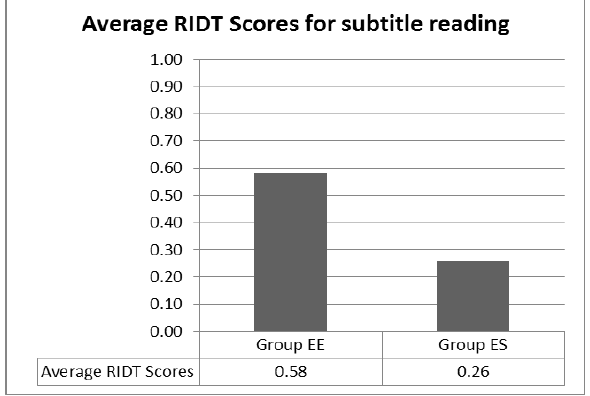
Figure 3. RIDT scores for subtitle reading In spite of the attention allocated to the subtitles, and contrary to previous research which found that subtitles increase academic performance, the current study found no statistical significance in the difference in perfor- mance between the groups. A one-way ANOVA between the three groups revealed no significant difference in either the first comprehension test completed directly after the video or the second comprehension test com- pleted two weeks later. There was a slight difference in comprehension scores in both tests (Figure 4). On aver- age, Group ES (63%) and Group E (64%) scored lower than Group EE (67%) in Test 1, although this difference was not statistically significant ( t (42)= .85, p > .05). Test 2 yielded different results, with Group ES outperforming the two other groups with an average of 58%, scoring better than both Group EE (51%) and Group E (54%) although neither of these differences were statistically significant.